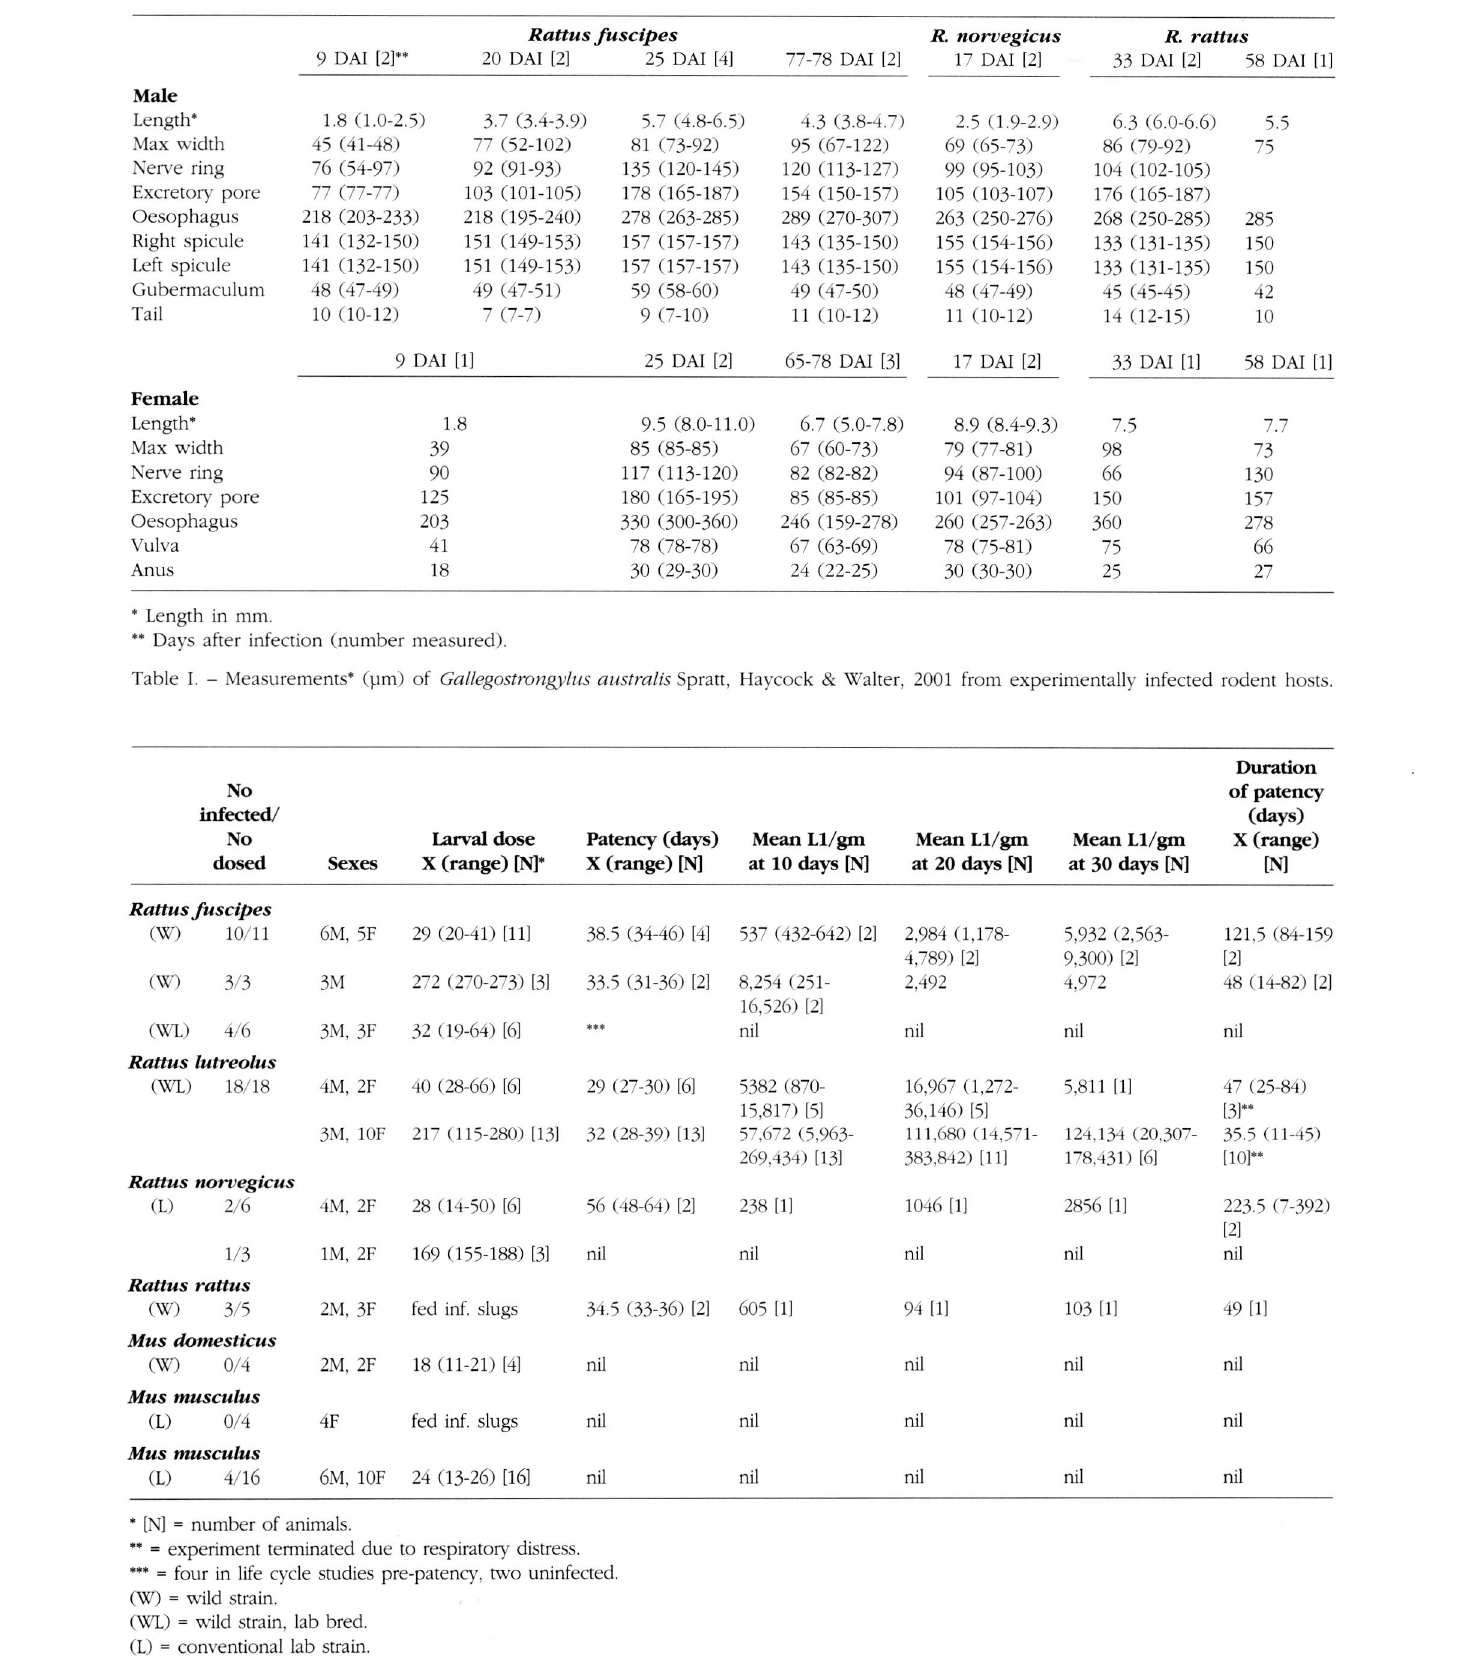
* [N] = number of animals. ** = experiment terminated due to respiratory distress.